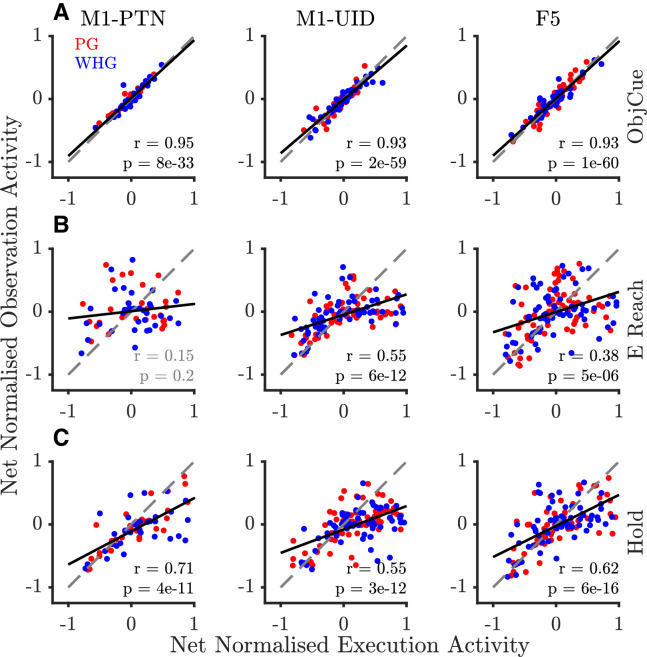
Execution and observation correlation scatter plots.(A) Scatter plot showing correlation across neurons between execution and observation during the Object Cue period in M1-PTNs (left), M1-UIDs (middle), and F5 (right). Dashed grey lines denote unity, and solid black lines denote line of best fit to data. Pearson correlation R values and corresponding p-values are shown in lower right of each subplot. PG and WHG are shown in red and blue, respectively, correlations are calculated across both grasps. (B) Same as (A), but for Early Reach epoch. (C) Same as (A), but for Hold epoch. M1-PTN plots are identical to insets in Figure 6.